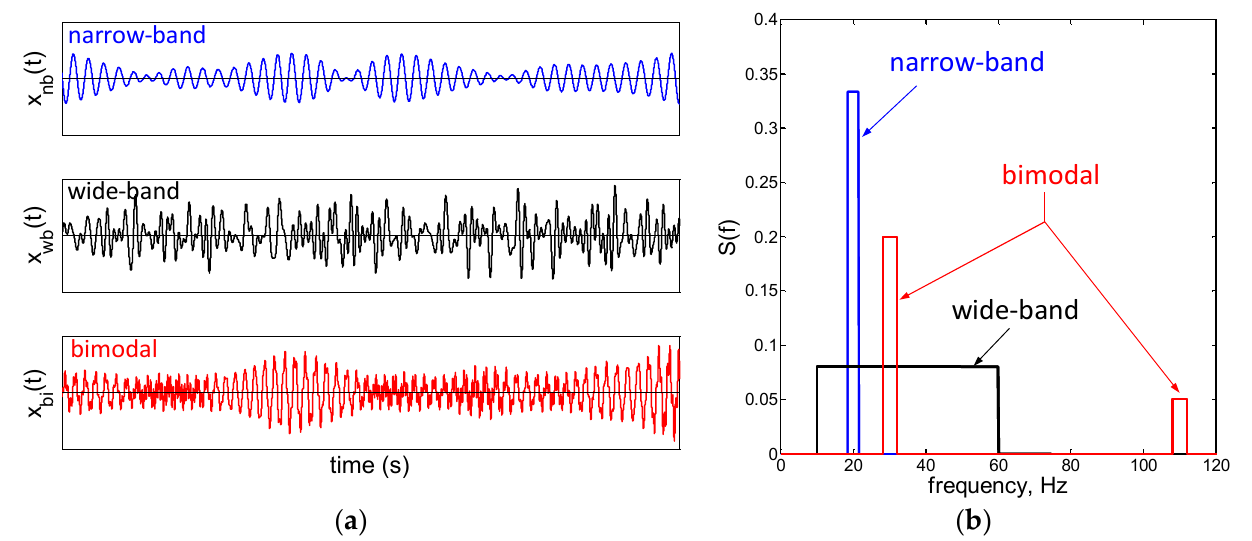
Figure 1. ( a ) Time history samples and ( b ) their PSD (narrow band, wide band, bimodal).